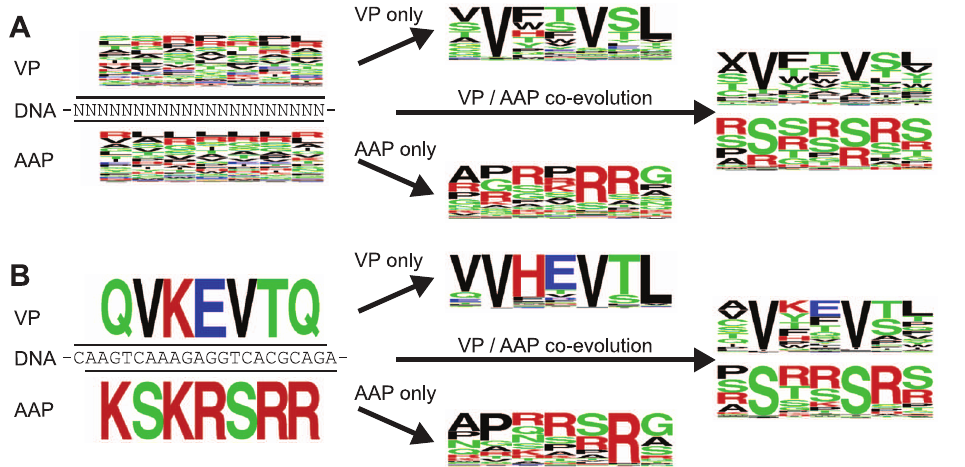
Figure 7. Amino acid frequency plots of computationally evolved VP and AAP heptapeptides. ( A ) Computational evolution of random nucleotide sequences. The in silico evolution was performed in three ways, VP only evolution without AAP-originating constraints, AAP only evolution without VP-originating constraints, and VP and AAP co-evolution. The amino acid logos to the left are a representative set of 200 ancestral sequences. The logos in the middle and to the right represent amino acid frequencies in all the individuals in the 200th generation. ( B ) The same analysis was done using the wild type AAV2 genome sequence.